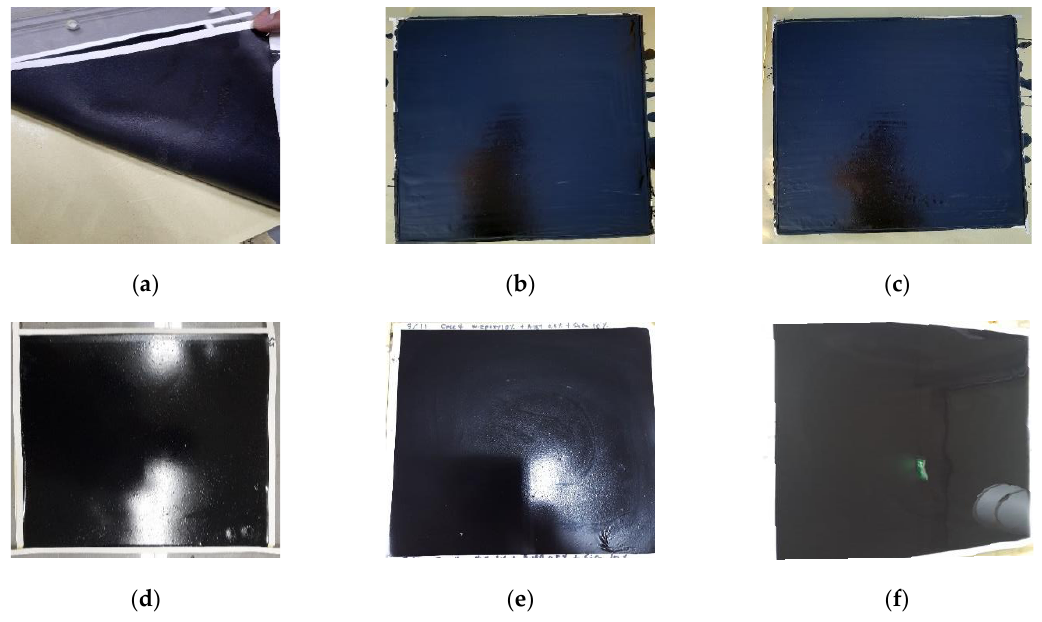
Figure 15. Hardened state of material in steady state. ( a ) Checking material separation; ( b ) steady- state coating; ( c ) steady-state coating; ( d ) steady-state coating; ( e ) steady-state coating; ( f ) steady- state coating.